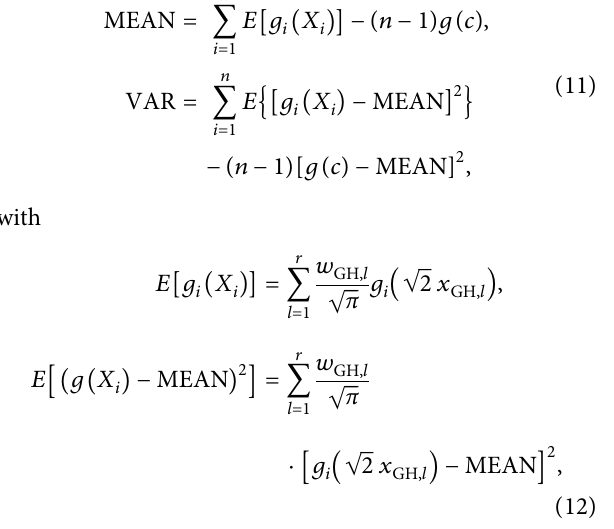
Table 1: G-H integration with r � 3 [33].